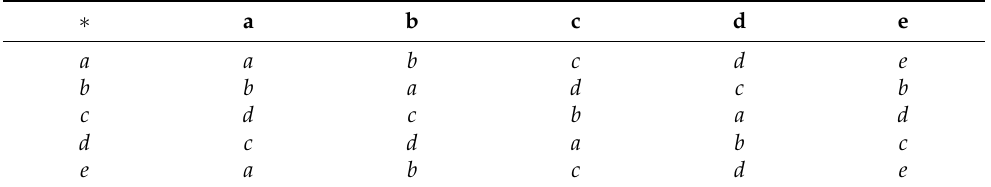
Table 3. This is an LR-transposition regular